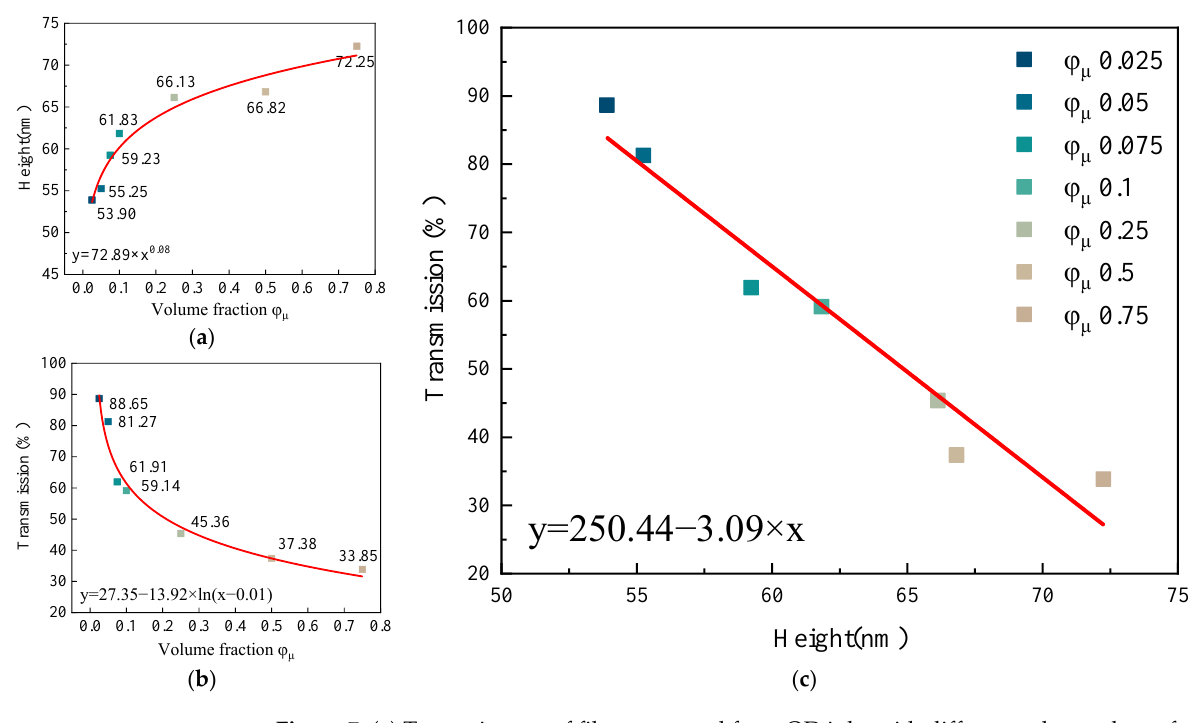
Figure 7. ( a ) Transmittance of films prepared from QD inks with different solute volume fractions. ( b ) Height of films prepared from QD inks with different solute volume fractions. ( c ) The fitting function of solute volume fraction and film transmittance.